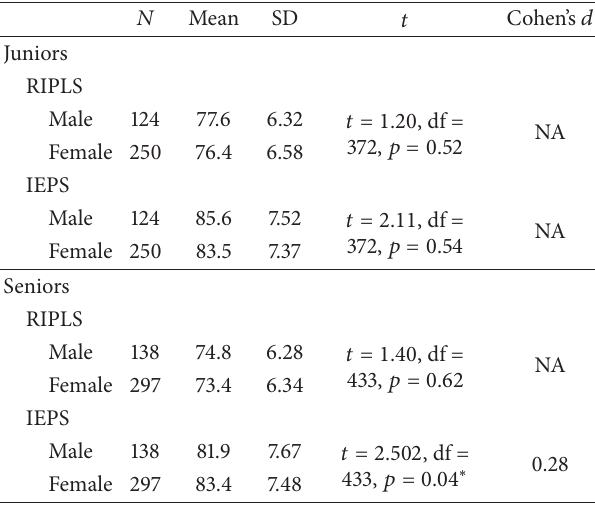
Table 2: Mean scores and significant differences of the RIPLS and IEPS by student